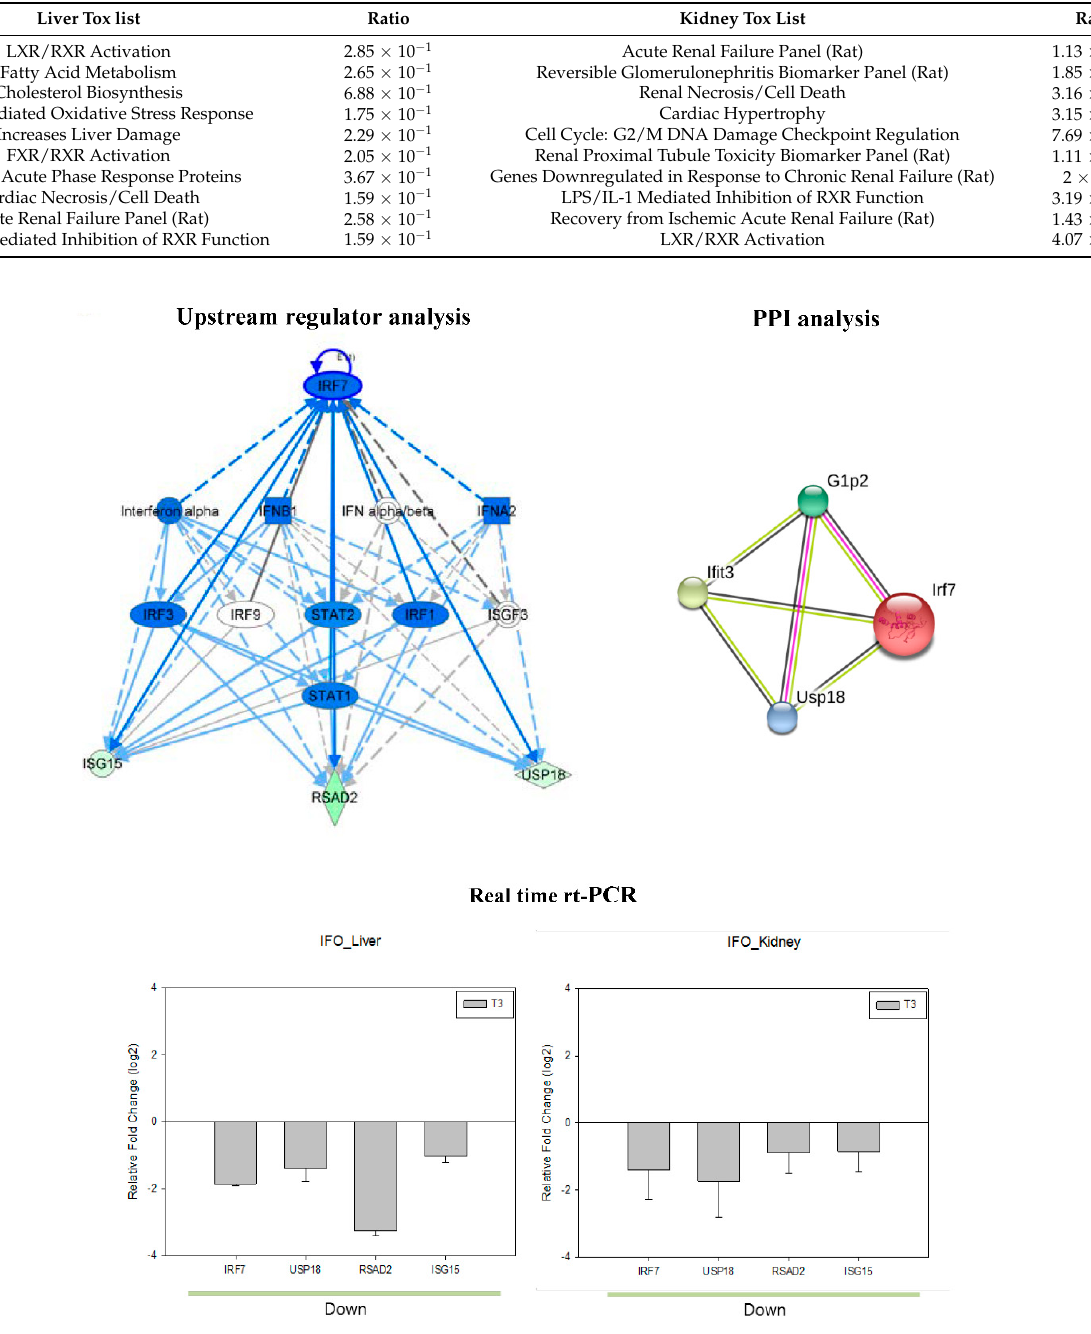
Figure 3. Upstream regulator and protein–protein interaction (PPI) network in ifosfamide toxicity. Upstream regulator analysis and PPI network analysis of the ifosfamide-induced DEGs and the expression of regulators in the liver and kidney were confirmed in the real-time rt-PCR analysis.